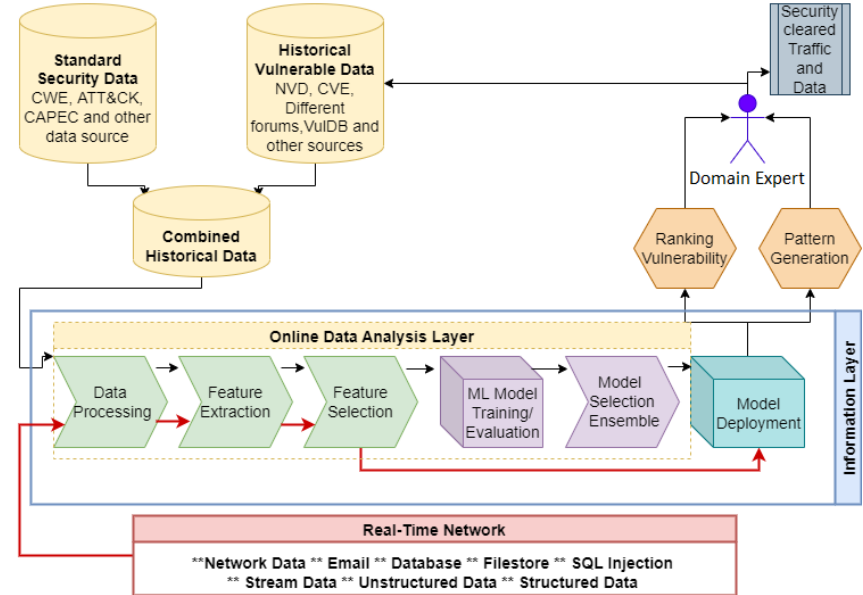
Figure 2. Flow chart of defense strategies in